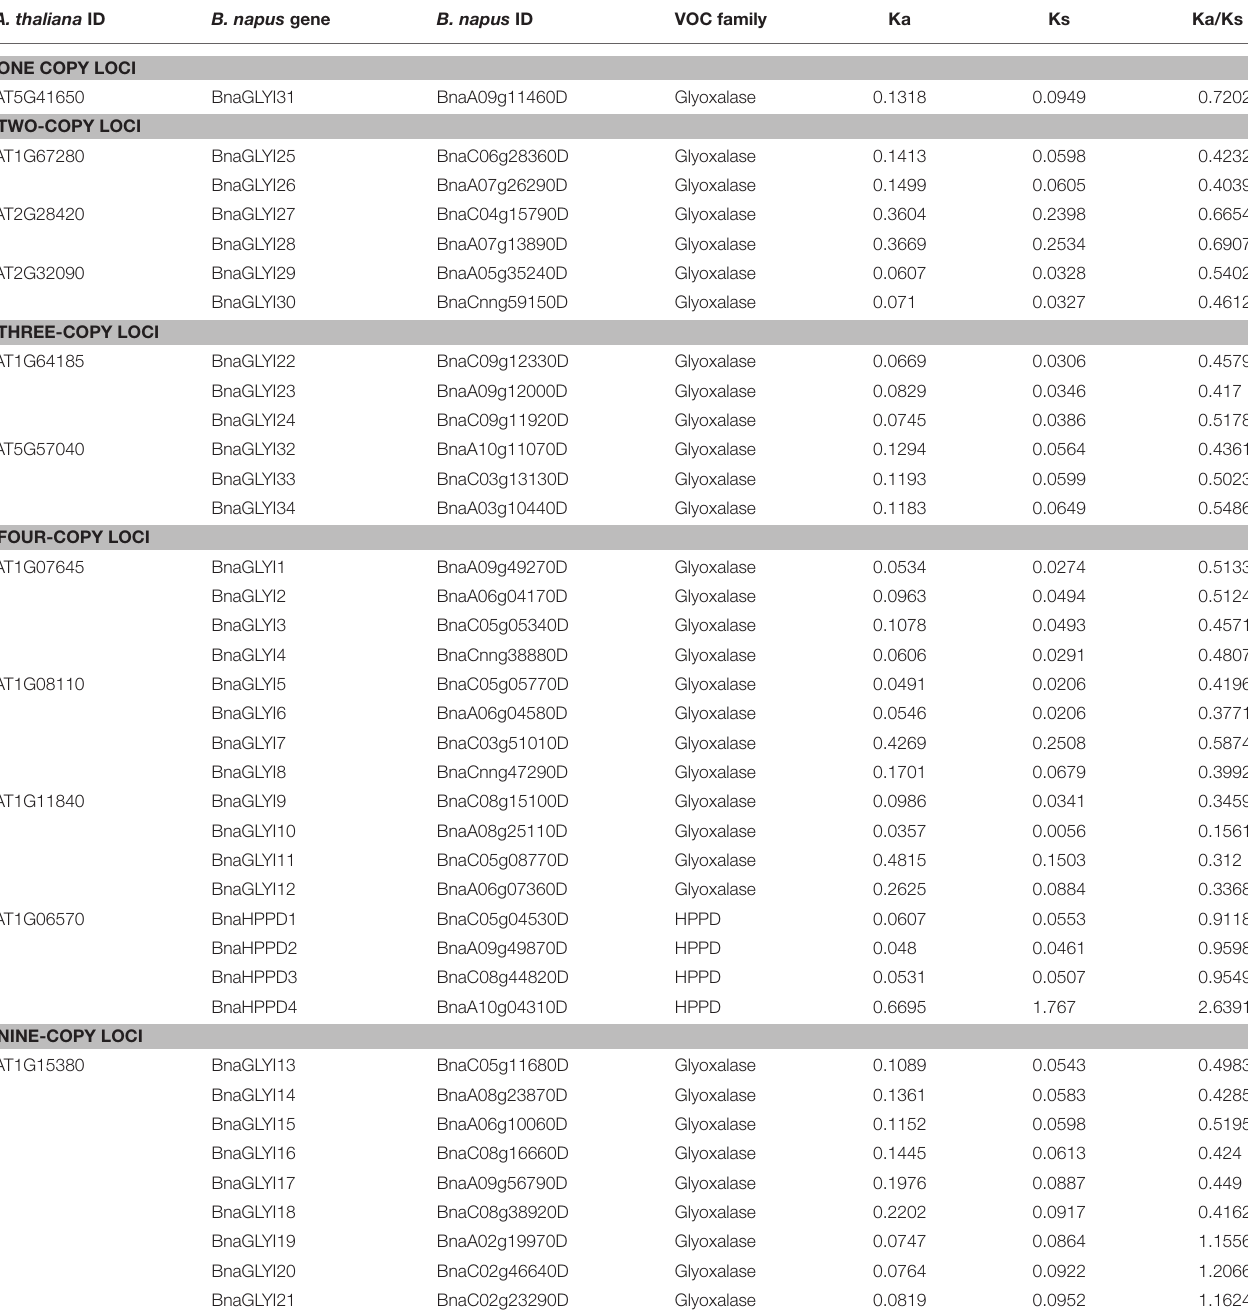
TABLE 2 | Non-synonymous (Ka) and synonymous (Ks) nucleotide substitution rates for Arabidopsis thaliana and B. napus VOC gene coding